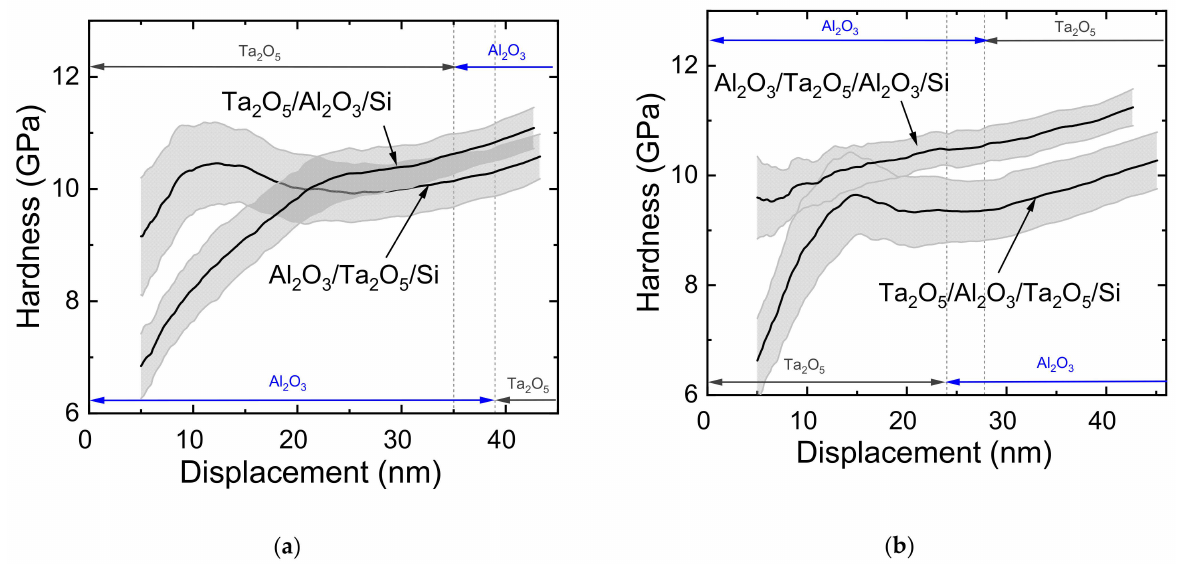
Figure 5. ( a ) Averaged hardness of 15 indents with standard deviation shown as grey areas. Vertical dotted lines and arrows indicate the thickness and sequence of layers for the double-layered laminates. ( b ) Averaged hardness of 15 indents with standard deviation shown as grey areas. Vertical dotted lines and arrows indicate the thickness and sequence of layers for the triple-layered laminates. Only two of the topmost layers are visualized on the